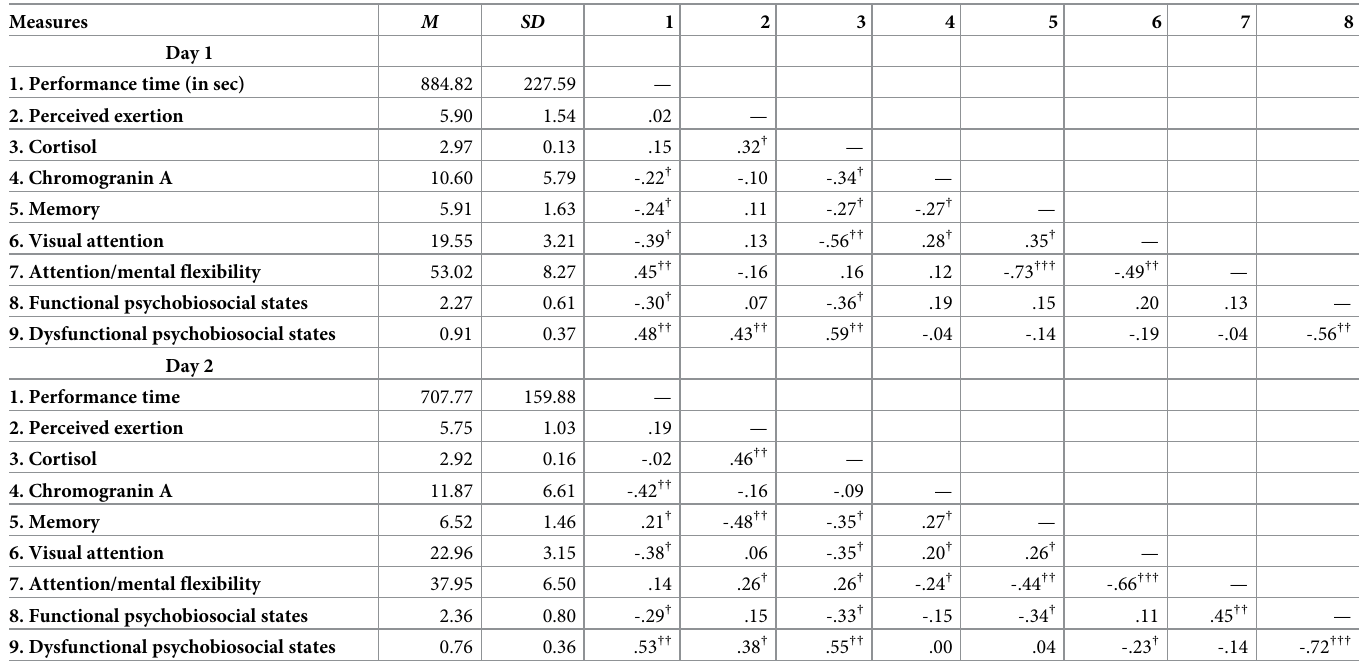
Table 1. Descriptive statistics and pearson correlation coefficients of mean scores of measures collected across the four loops of the orienteering course.